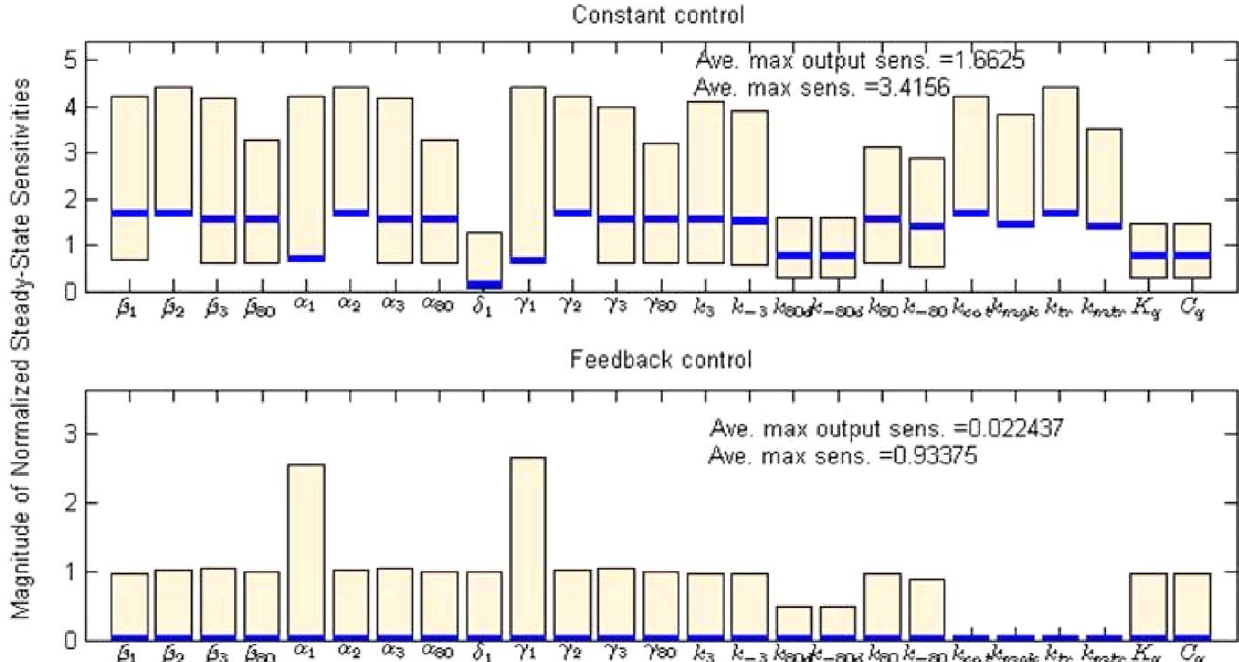
Figure 9. Comparison of normalized steady-state sensitivities (NSSS) between constant and feedback control. The NSSS of the feedback control case has significantly smaller magnitude in terms of average maximal sensitivities for all states (0.93 v.s. 3.42) and the output state (0.02 v.s. 1.66). The bars describe the maximum and minimum values of NSSS of the states with respect to each parameter. The solid lines denote the output NSSS on each parameter. doi:10.1371/journal.pone.0019353.g009 PLoS ONE |